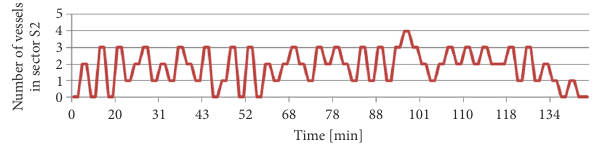
Figure 5. Number of crossing vessels in sector S2